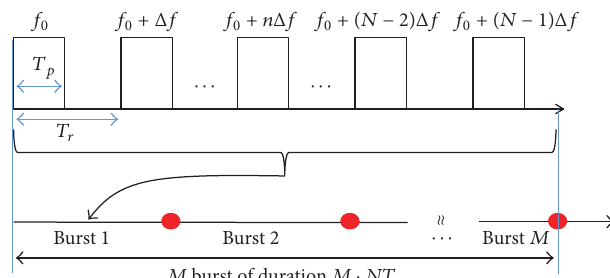
Figure 1: A frequency stepped